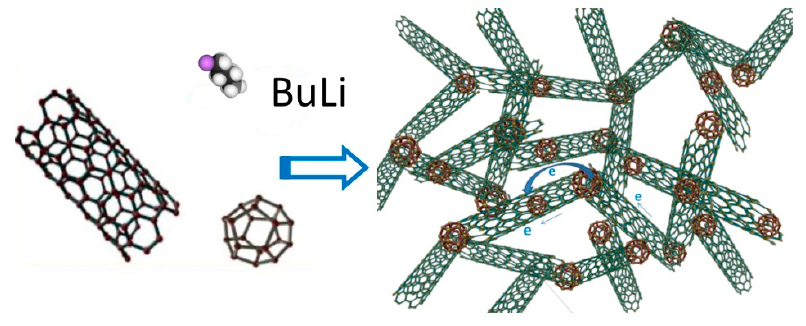
Figure 1. Schematics for synthesis of CNT-g-C60.